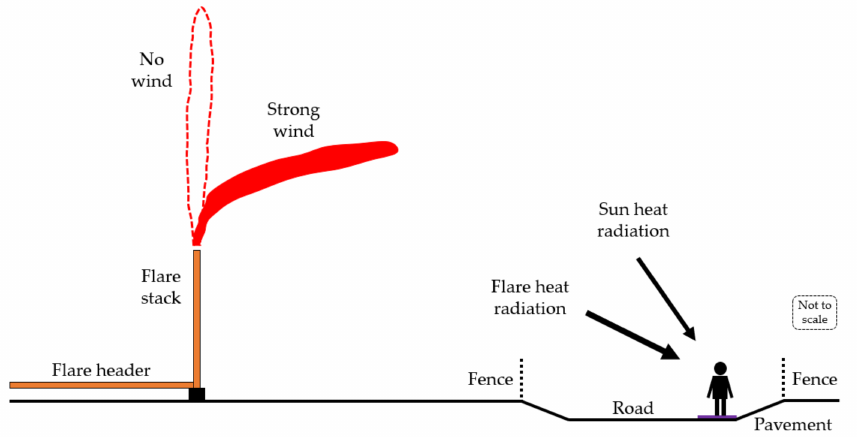
Figure 1. Principal sketch of flare flame heat exposure in varying wind